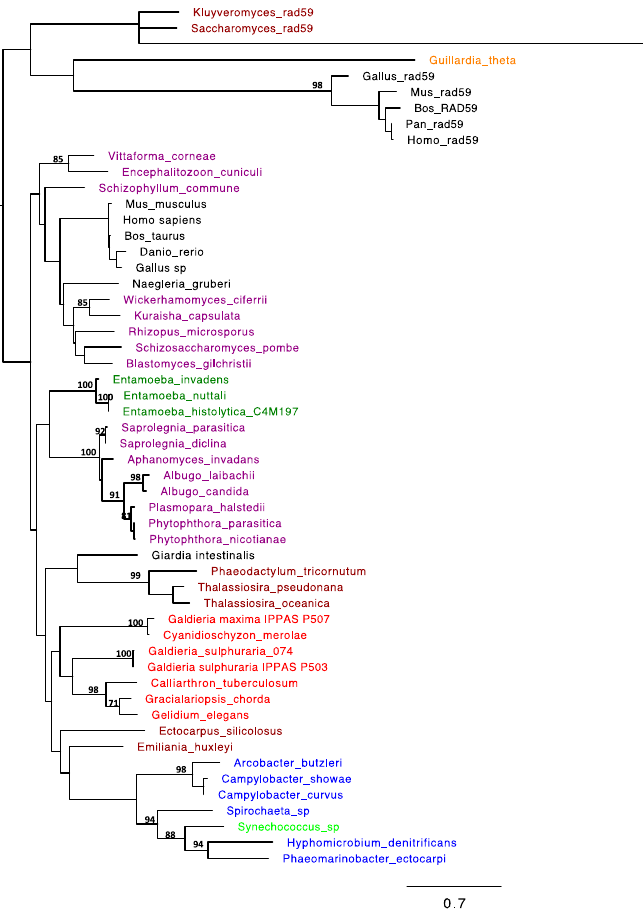
Figure 1. RAD52 homologs, rooted with the RAD52 paralogs outgroup; 140 aligned amino acid sites from 54 taxa were analyzed; this consensus topology derived from >21.000 trees, α = 1.86 (1.45 < α < 2.28), pI = 7.269 × 10 − 3 (7.4239 × 10 − 8 < pI < 0.0217) and lnL = − 8952.79. Different colors were used for different taxonomic categories: dark brown, yeasts; orange, cryptophytes; black, mammals; purple, fungi; dark green, amebozoa; light brown, heterokontophytes; blue, bacteria; light green, cyanobacteria.